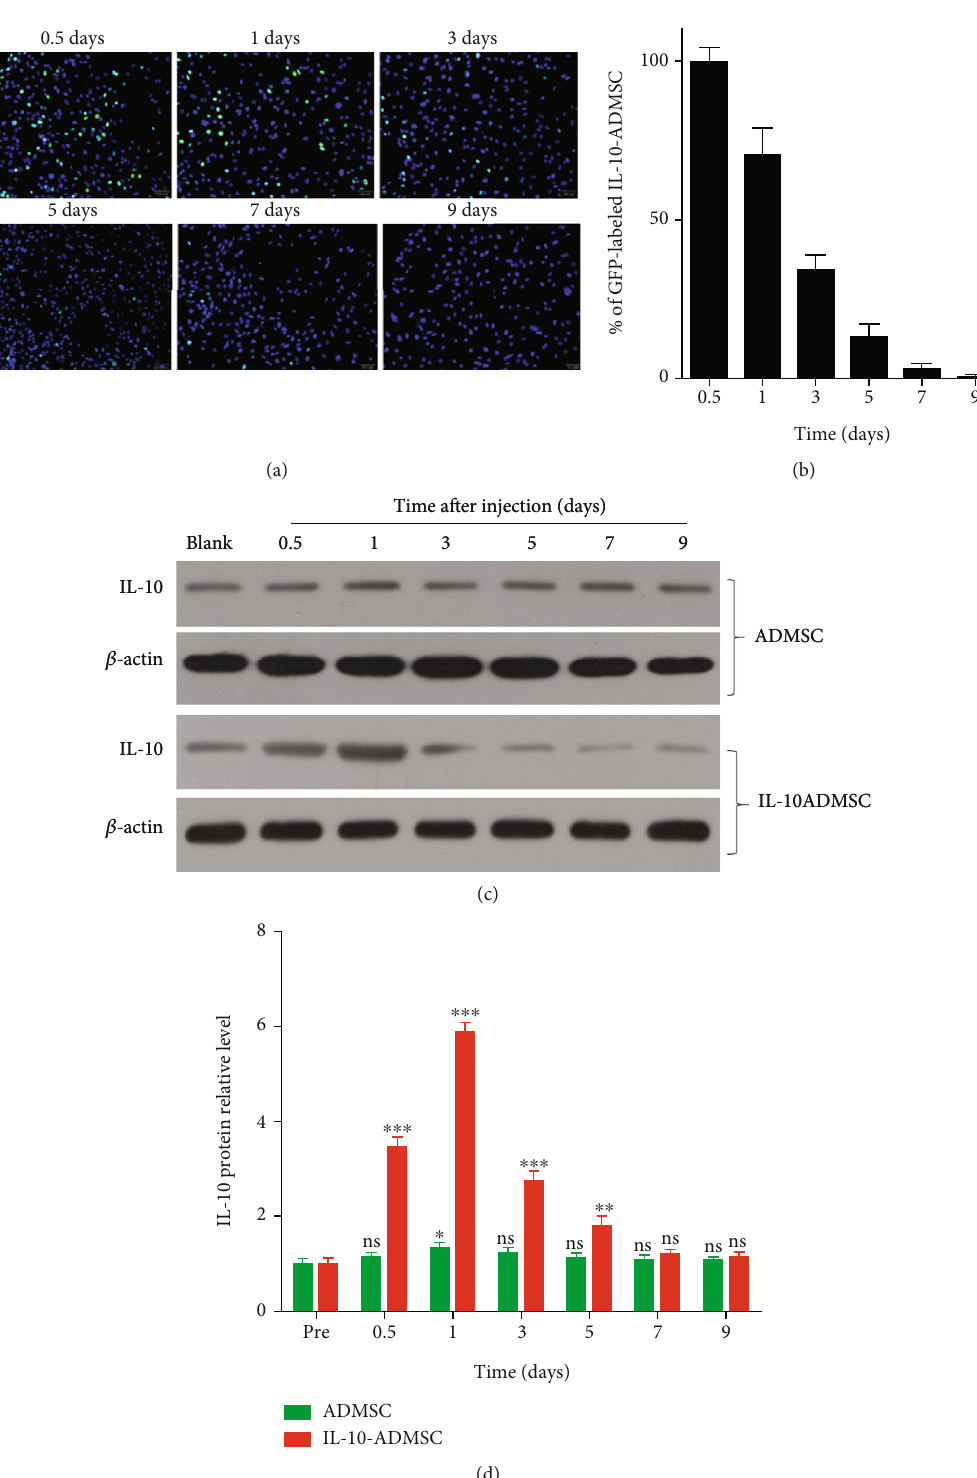
Figure 5: IL-10-modi fi ed ADMSC underwent extensive apoptosis and survived for a short time after injection. (a) In the wound, the locally injected IL-10-ADMSC gradually reduced which was evaluated by observing green fl uorescence, and representative tissue fl uorescence image was displayed; (b) the GFP-labeled IL-10-ADMSC in the wound after di ff erent time of local injection of IL-10-ADMSC were statistically compared; (c – d) after di ff erent time of local injection of IL-10-ADMSC, Western blot was used to detect the expression of IL-10 in the wound. Representative protein bands were displayed and statistically compared protein band gray value. Scale bar: 10 μ m. Data was expressed as ( SD ± mean ), and each analysis was repeated at least 3 times independently; P value was calculated by Student ’ s t test; ns was P > 0 : 05 , ∗ was P < 0 : 05 , ∗∗ was P < 0 : 01 , and ∗∗∗ was P < 0 : 001 vs. ADMSC